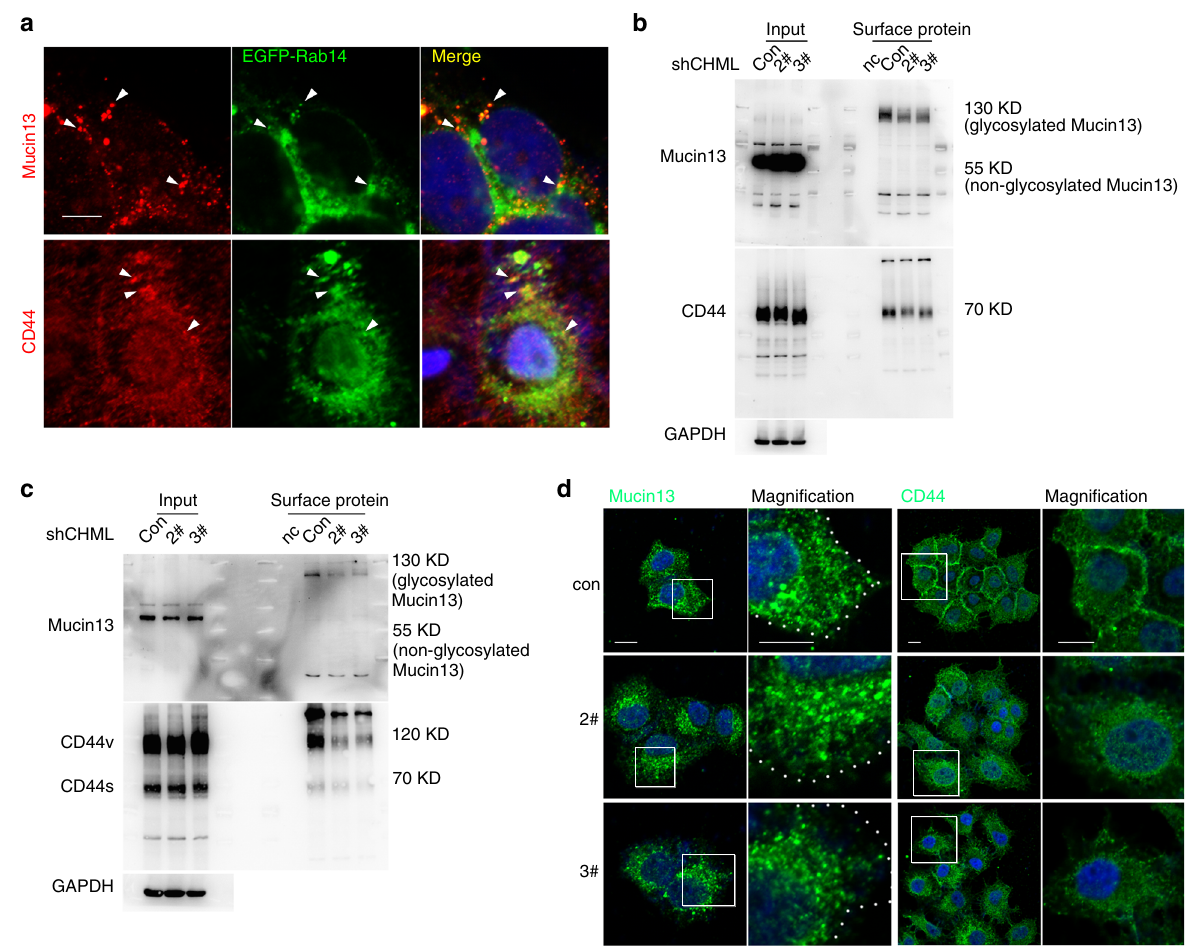
Fig. 8 CHML KD in fl uences membrane localization of CD44 and Mucin13. a Representative images showing Mucin13 and CD44 were partially co-localized with EGFP-Rab14 in CSQT-2 cells. Scale bar, 20 μ m. White arrowheads indicated merge sites. b , c Western blot analysis of indicated surface protein in YY- 8103 ( b ) and CSQT-2 cells ( c ). d Representative images showing endogenous distribution of CD44 and Mucin13 both in YY-8103 control and